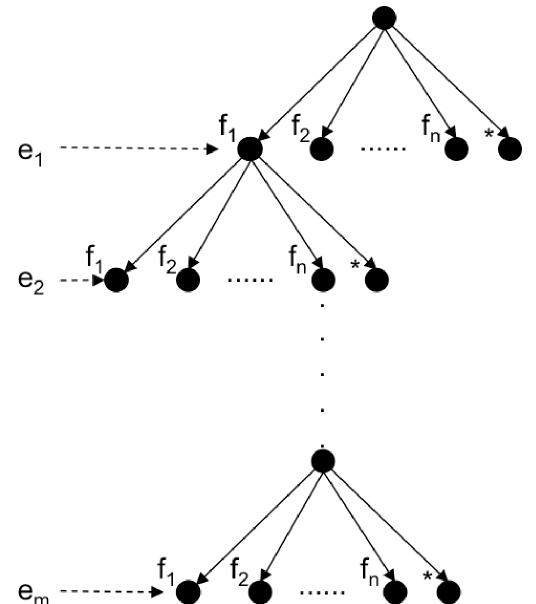
Figure 7. Interpretation tree stating, for each object e i (level i ) its potential associations f 1... n , repre- senting the (*) node, a spurious